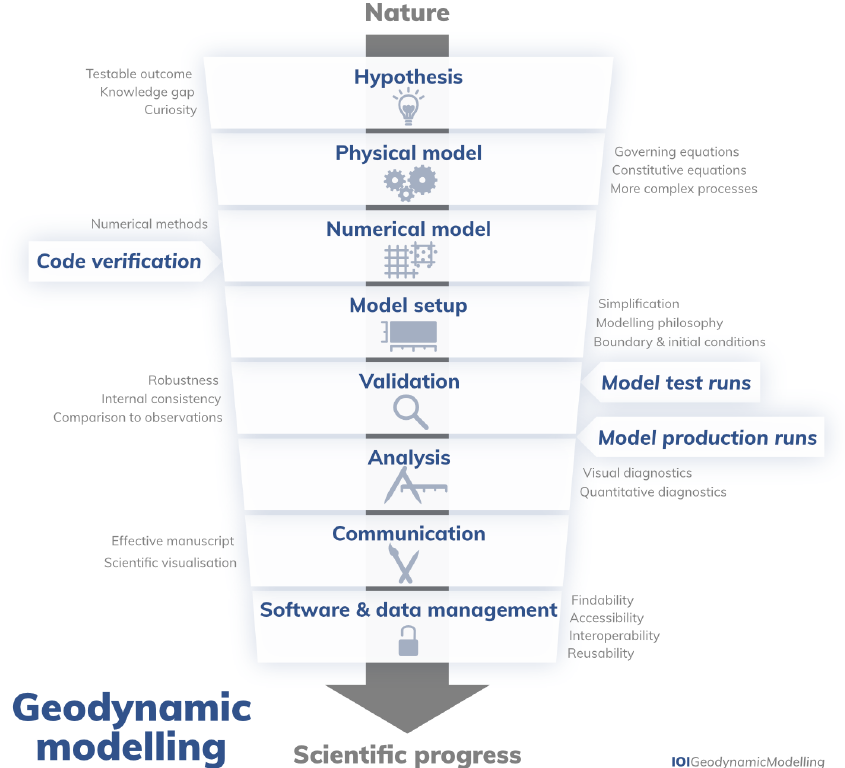
Figure 2. The geodynamic modelling procedure. A modelling study encompasses everything from the assemblage of both a physical (Sect. 2) and a numerical model (Sect. 3) based on a verified numerical code (Sect. 4), to the design of a simplified model setup based on a certain modelling philosophy (Sect. 5), the validation of the model through careful testing (Sect. 6), the unbiased analysis of the produced model output (Sect. 7), the oral, written, and graphical communication of the modelling approach and results (Sect. 8), and the management of both software and data (Sect. 9). Note that constant (re-)evaluation and potential subsequent adjustments of previous steps are key, and indeed necessary, throughout this